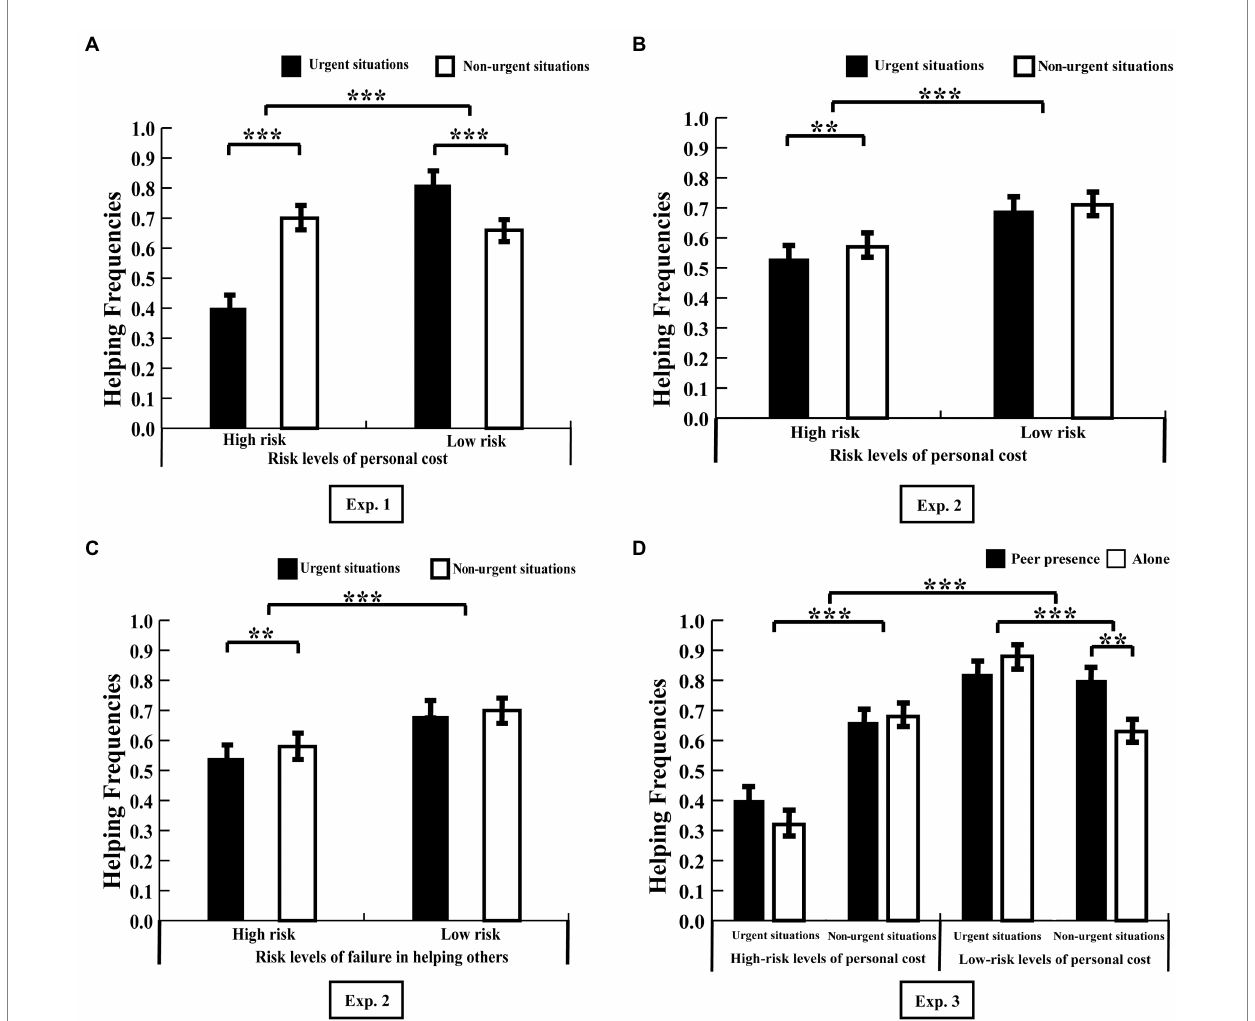
FIGURE 2 Helping frequencies under each condition in Experiment 1 (A) , Experiment 2 (B,C) , and Experiment 3 (D) . Error bars were drawn from the standard deviation and reflected 95% confidence intervals. ** p < 0.01, *** p <